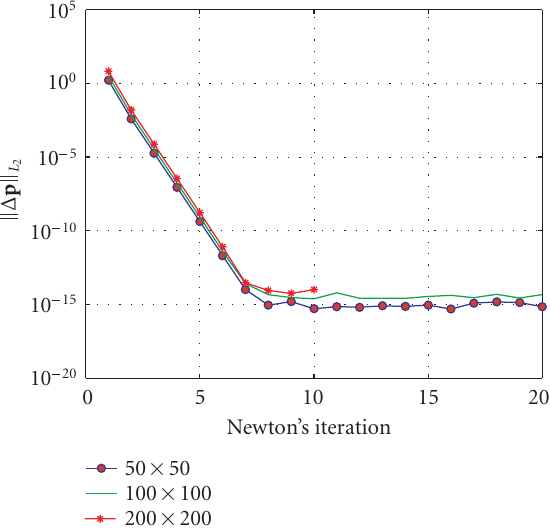
Figure 4.2 . Example 4.1: Newton’s iteration versus norm of the di ff erence vector (cid:4) Δ p (cid:4) L